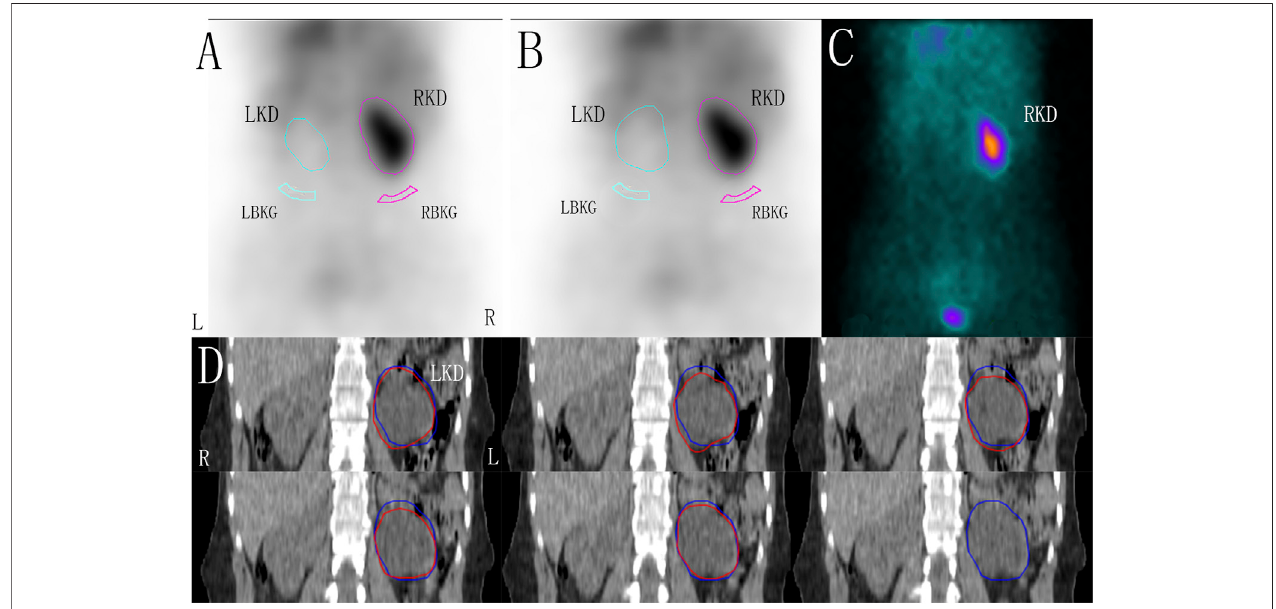
FIGURE 1 | The renal region of interest (ROI) was corrected by computer tomography (CT) in a patient with left hydronephrosis, zoom: 1.5. (A) ROI of the kidneys andthebackgrounddrawnusingtheGatesmethod. (B) BasedonthemaximumrenalROIareacorrectedbyCT,theROIofthekidneysandthebackgroundswasdrawn using the Gates method. (C) One-minute frames: shows the frame-per-minute image overlaid by the kidneys, cortex, background, and bladder. (D) ROIs of the left kidney were delineated layer by layer on CT coronal sectional images (red line), and the maximum ROI area of the kidney were redrawn and used as the renal ROI area from CT (blue line). LKD, left kidney; RKD, right kidney; LBKG, left background; RBKG, right